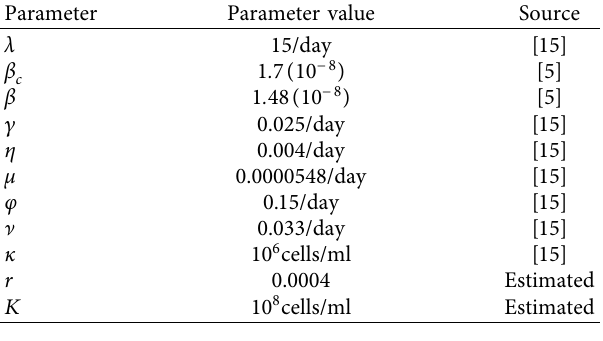
Table 1: Description of the parameter value and source.